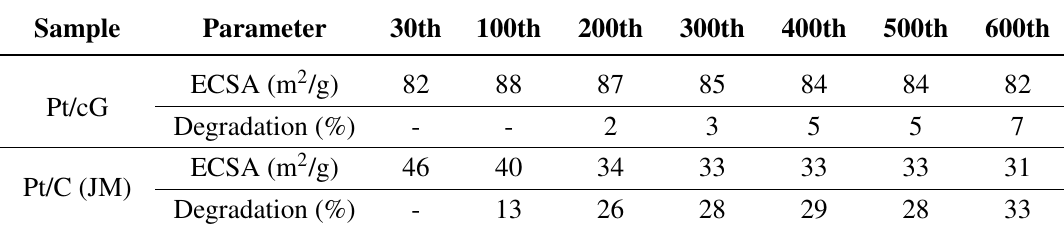
Table 3. Calculated ECSA (m 2 /g) and activity degradation (%) of the samples. Sample